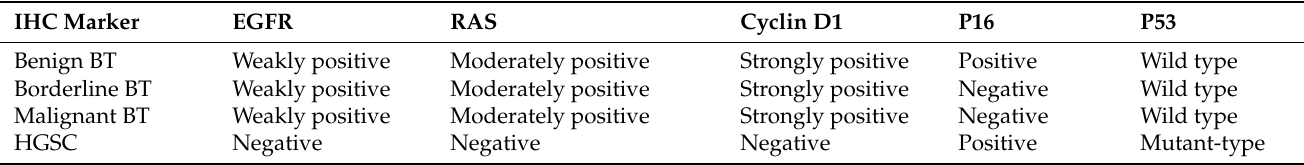
Table 3. Immunohistochemical characteristics of BTs and high-grade serous